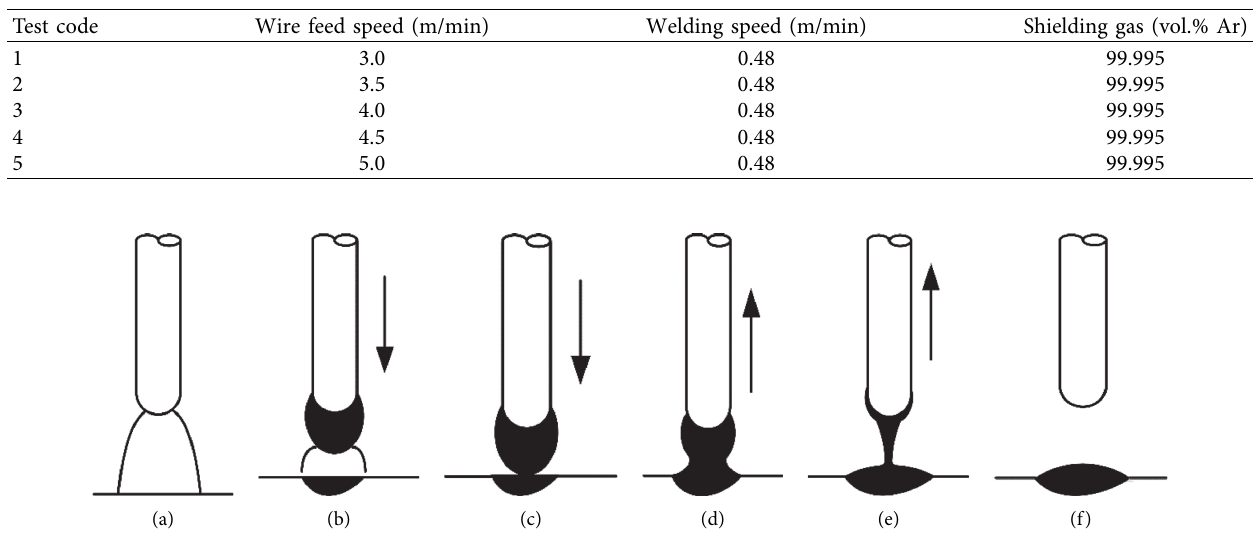
Figure 3: Short-circuit transfer in CMT. Table 2: Physical parameter values used for calculations.